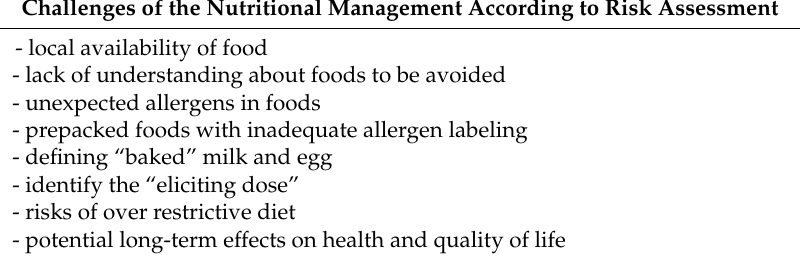
Table 1. Nutritional management according to risk assessment: What are the challenges? Challenges of the Nutritional Management According to Risk